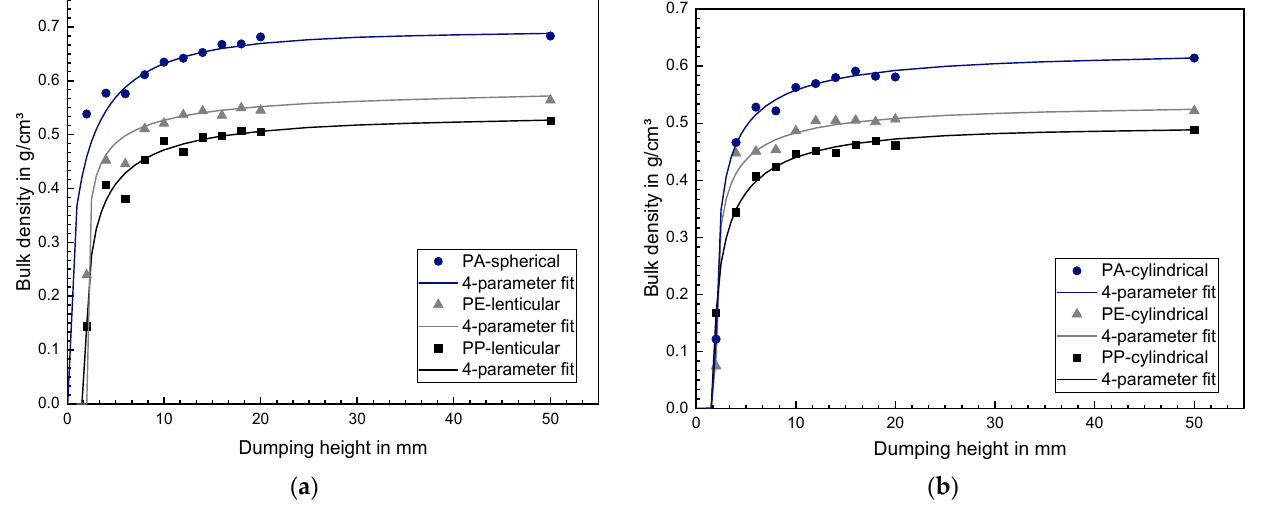
Figure 5. ( a ) Bulk density as a function of dumping height for spherical PA, lenticular PE and lenticular PP ( b ) Bulk density as a function of dumping height for cylindrical PA, cylindrical PE as well as cylindrical PP.